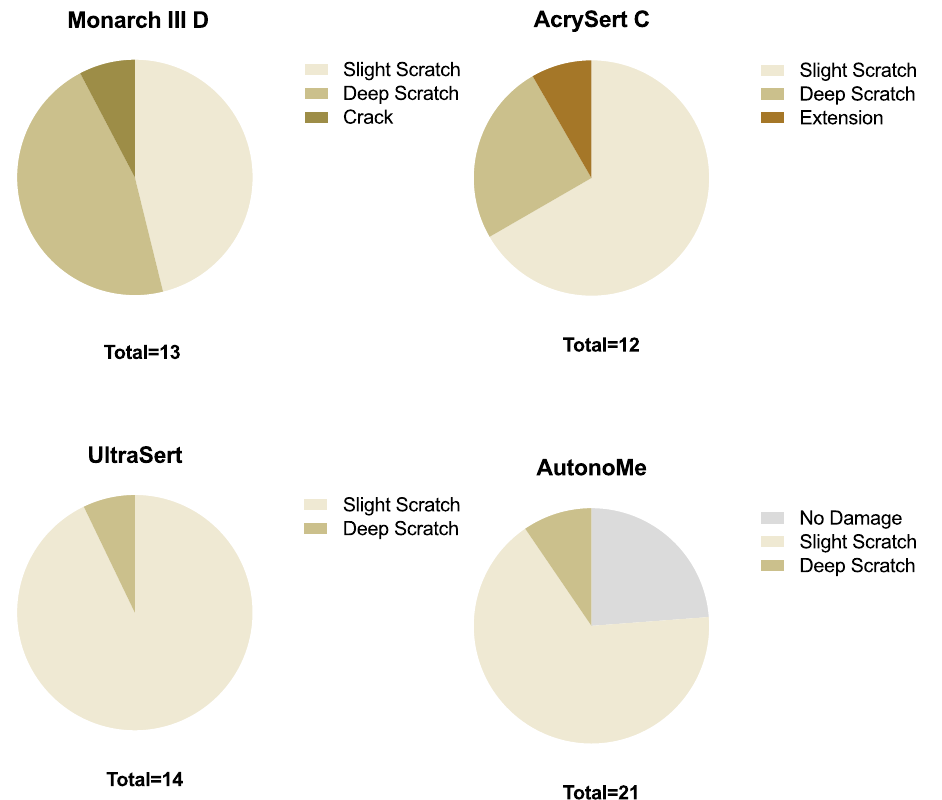
Figure 2. The distribution of damage profile of 4 injector groups.